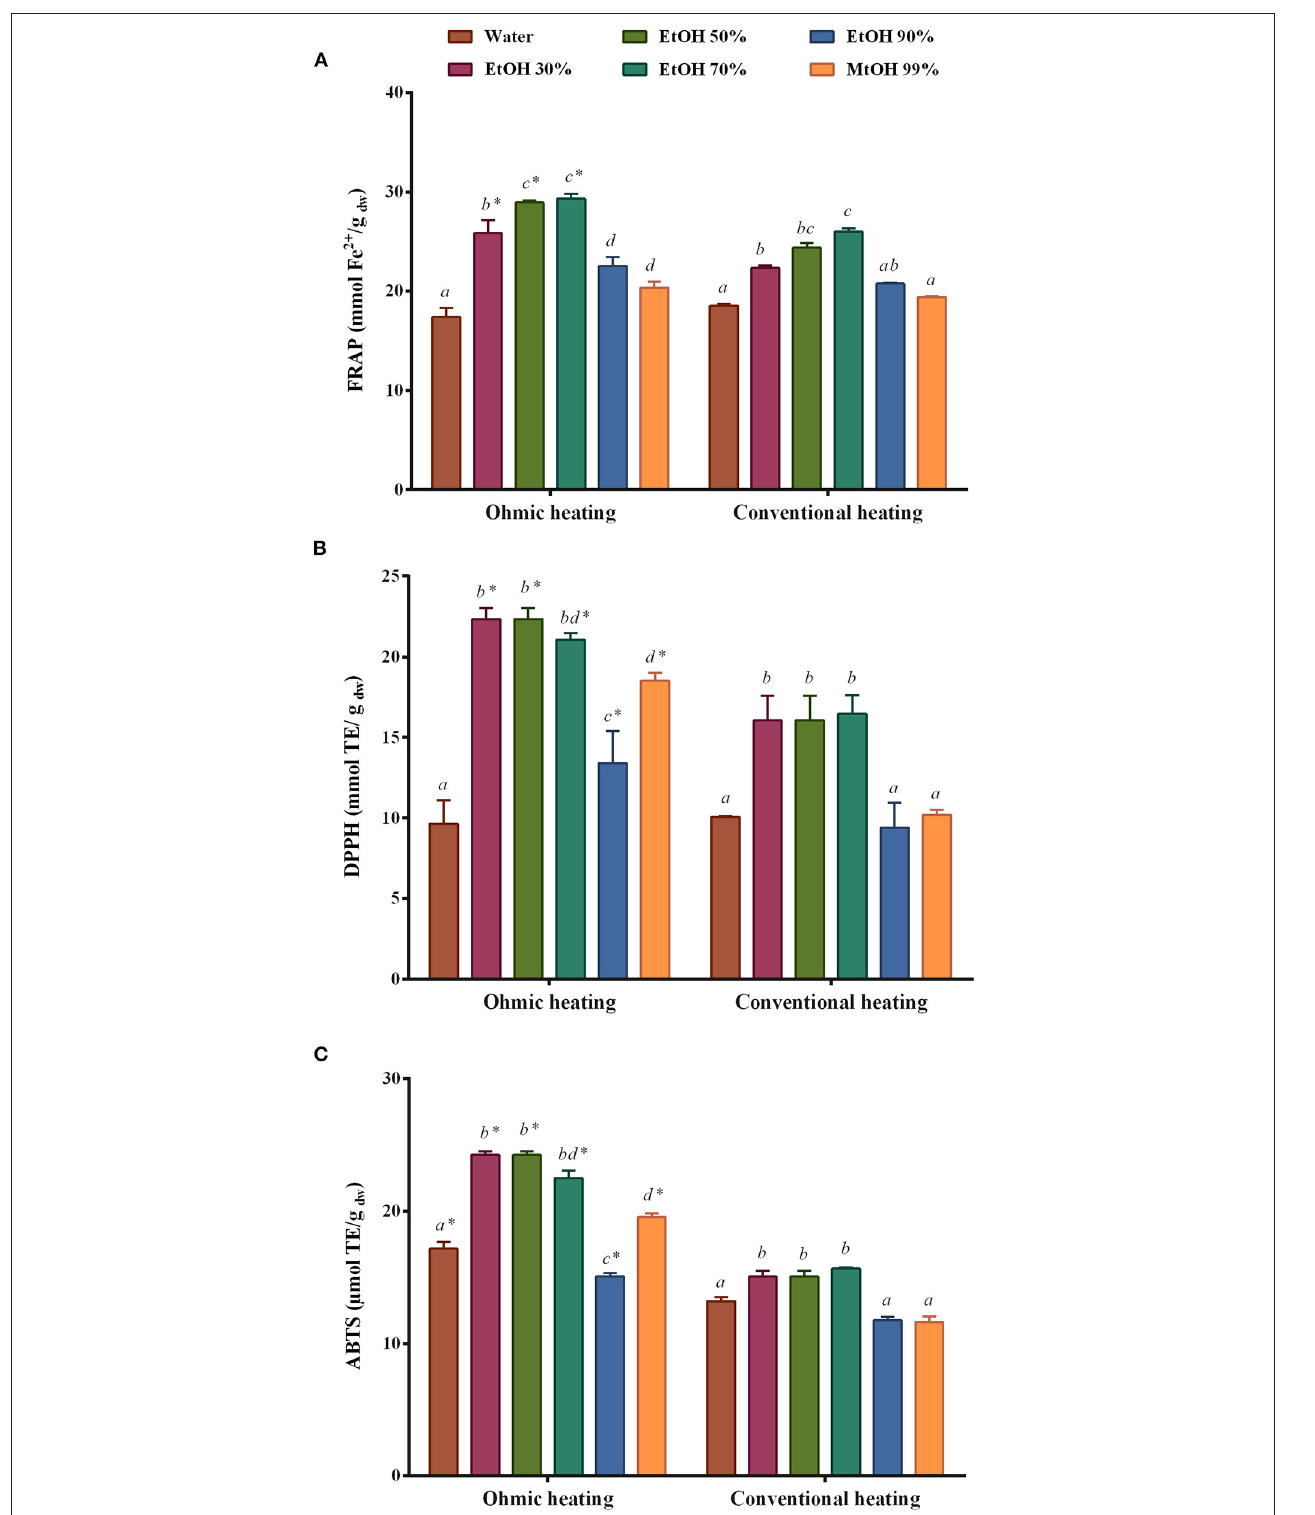
FIGURE 4 | Antioxidant activity of Red eggplant extracts using three different method FRAP (A) , DPPH (B) , and ABTS (C) . Influence of solvents using conventional heating and OH-assisted extraction methods. Values are expressed as mean ± SD. Different letters show significant differences ( p < 0.05) between extraction solvents for the same extraction technologies. *Show significant differences ( p < 0.05) between extraction technologies for the same solvent.